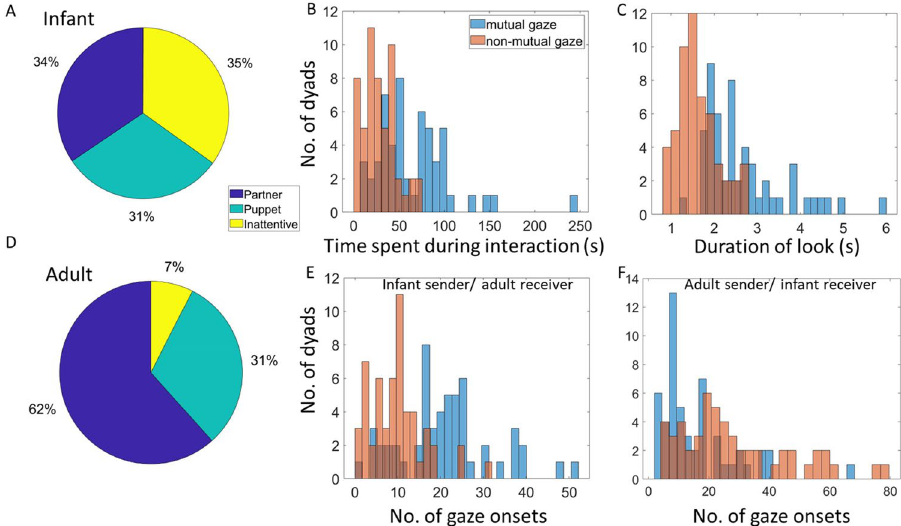
Figure 2. Distribution of gaze onsets in our sample. ( A ) Distribution of time infants spent looking at different areas. ( B ) Distribution of time dyads spend in mutual and non-mutual gaze during interaction. ( C ) Distribution of look durations for mutual and non-mutual gaze defined from infants’ look behaviour. ( D ) Distribution of time adults spent looking at different areas. ( E ) Distribution of infant sender/adult receiver mutual and non- mutual gaze onsets. ( F ) Distribution of adult sender/infant receiver mutual and non-mutual gaze